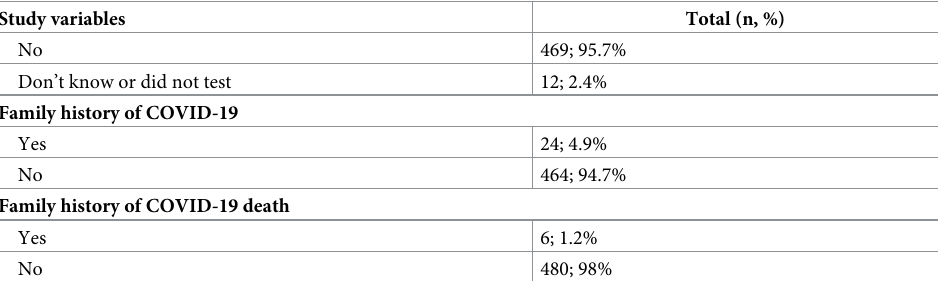
PLOS ONE | https://doi.org/10.1371/journal.pone.0279271 December20,